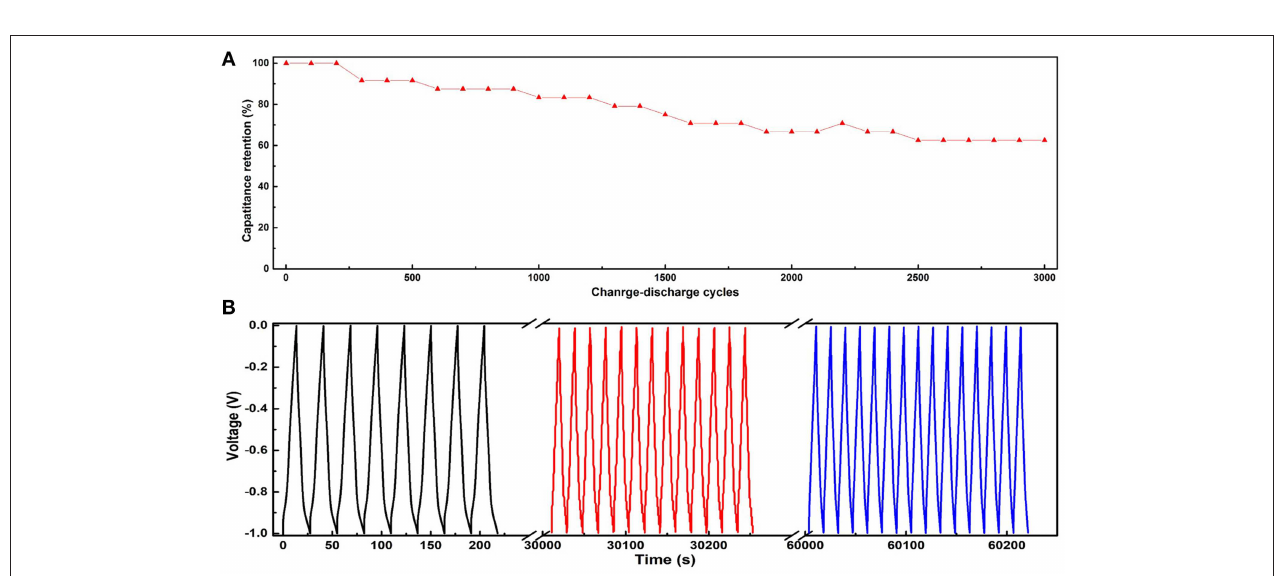
FIGURE 3 | (A) The CV curves of COP BTC -Mn/CF-4 ( α is quality of COP BTC -Mn, and α = 0, 1, 2, 3, and 4mg, respectively) in the voltage range of − 1 to 0V at scanning rate of 10 (black), 20 (red), 50 (blue), 100 (pink), 200 (green), and 400mV s − 1 (orange), and commercial carbon felt (CF) at a scan rate of 100mV s − 1 (yellow). (B) Charge–discharge profiles of COP BTC -Mn/CF-4 at current densities of 10 (orange), 5 (green), 2 (pink), 1 (blue), 0.5 (red), and 0.2 Ag − 1 (black), respectively. (C) Capacitance of COP BTC -Mn/CF- α at different current densities.